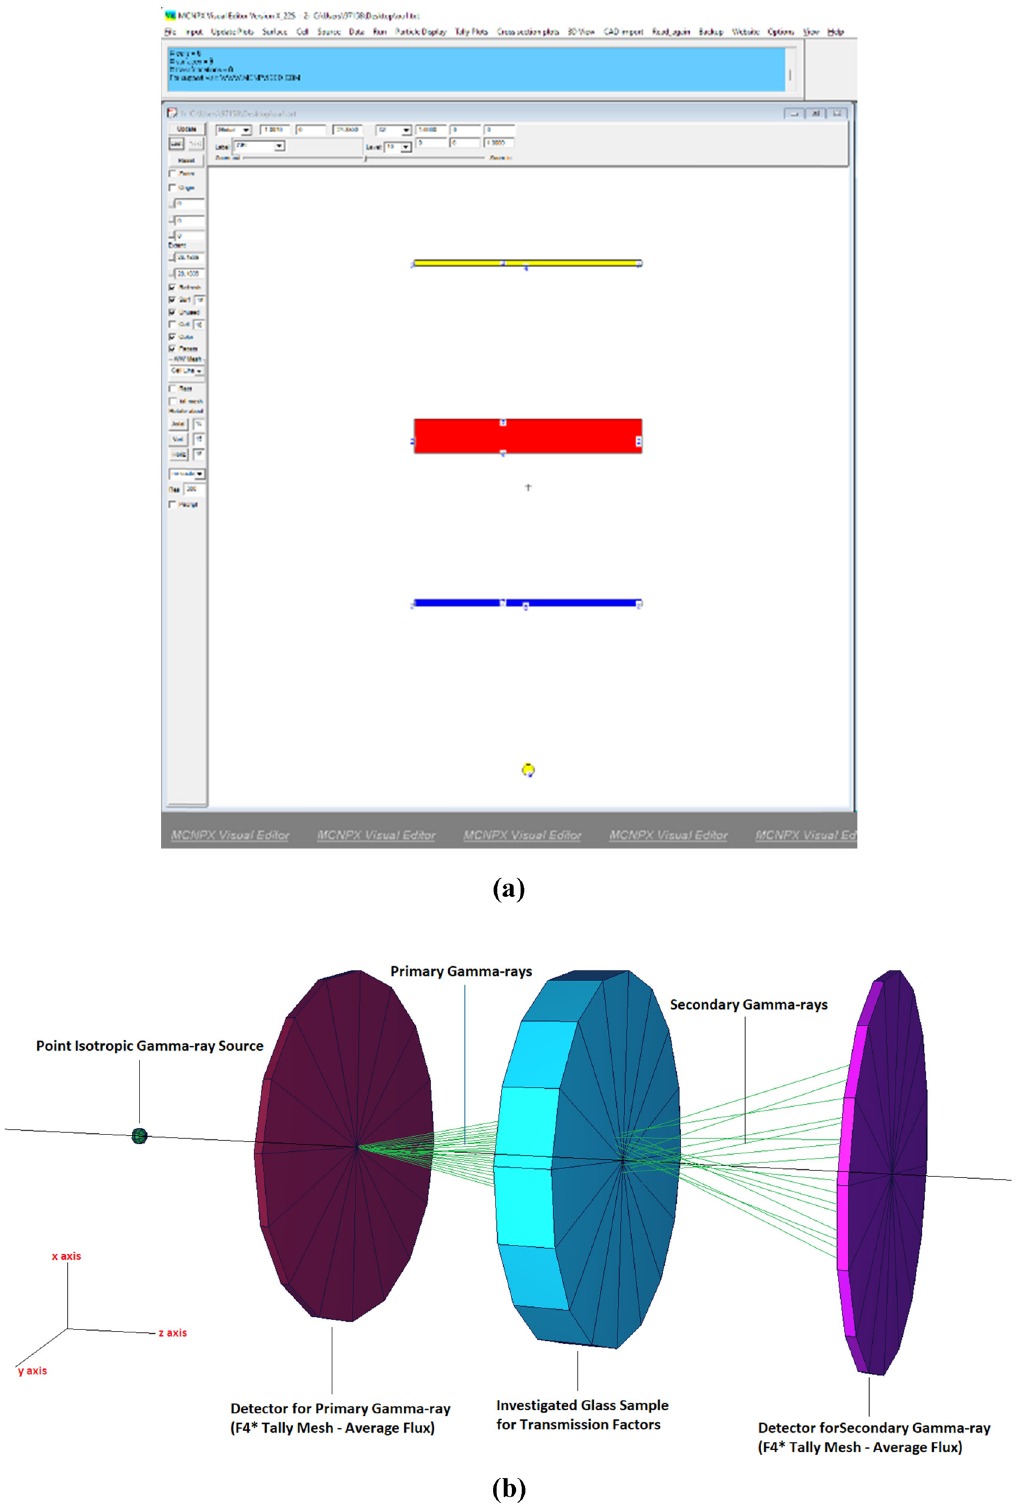
Figure 1: ( a ) 2 - D view of the designed MCNPX simulation setup and ( b ) 3 - D illustration of designed MCNPX setup ( 2 - D and 3 - D views are obtained from MCNPX Visual Editor VisedX22S )